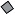
Parameter estimates for fertile and sub-fertile sub-cohorts and
associated fecundability values.Values are shown for Wilcox (□), Zinaman (▲) and Wang ( ) studies. Panel A shows
the proportions in the starting cohorts modelled as fertile or sub-fertile (
%fert
(1) & %subf
(1)). Panel B shows the hCG ( FEC HCG) and clinical ( FEC CLIN) fecundabilities and the probability of hCG pregnancies
progressing to clinical pregnancies ( π CLIN). Values are derived from modelled parameter estimates ( Table 1) and error bars indicate 95%
confidence intervals.